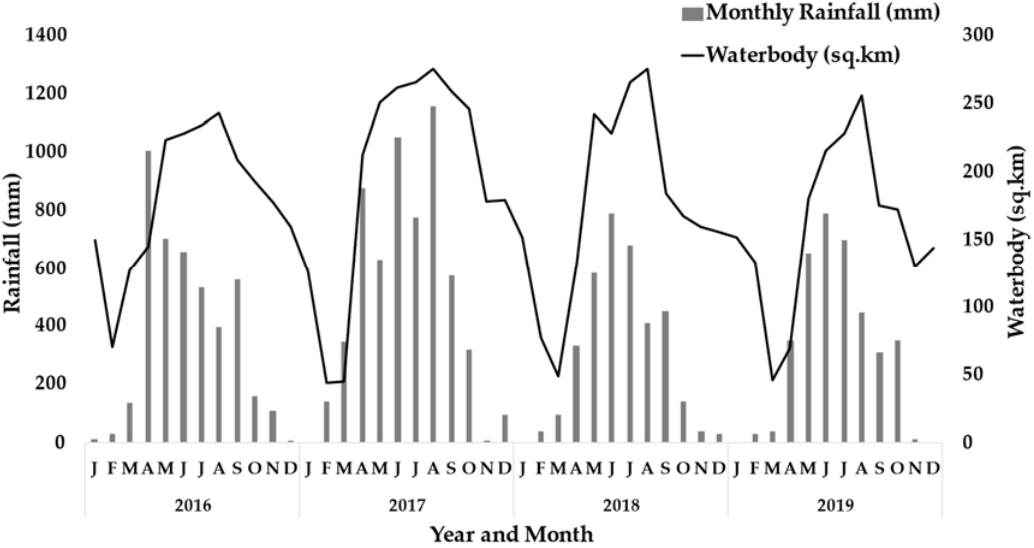
Figure 3. Changes in monthly rainfall and waterbody size within Hakaluki Haor.